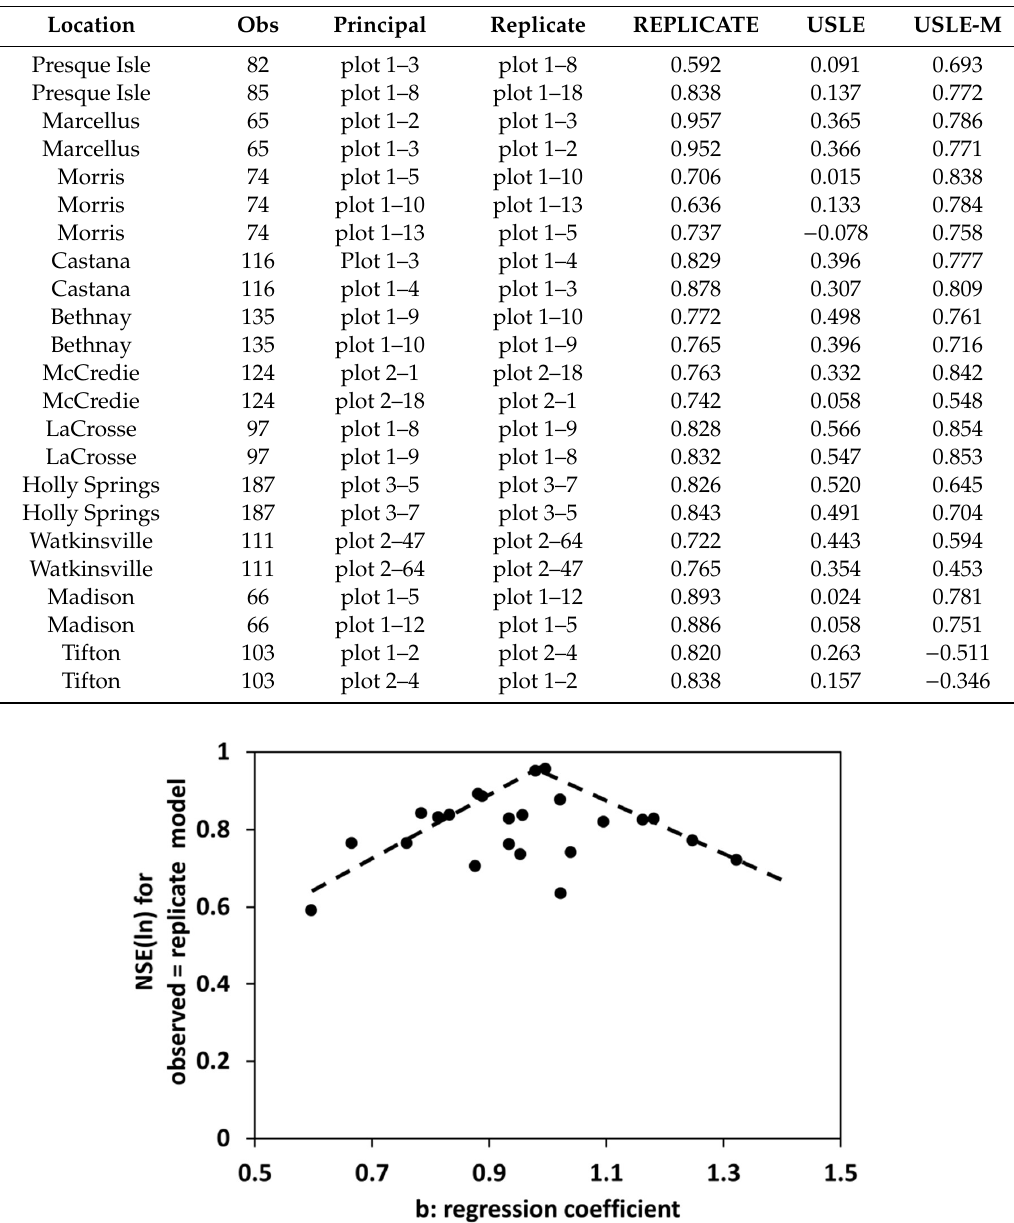
Figure 16. Relationships between observed event soil loss and loss from a replicate; EI 30 and Q R EI 30 values for storms on plots at Morris, MN and Tifton, GA (source Kinnell [63]). Table 6. NSE(ln) values when USLE, USLE-M, and replicate models were applied to bare fallow plots in the USLE database (source: Kinnell [63]).